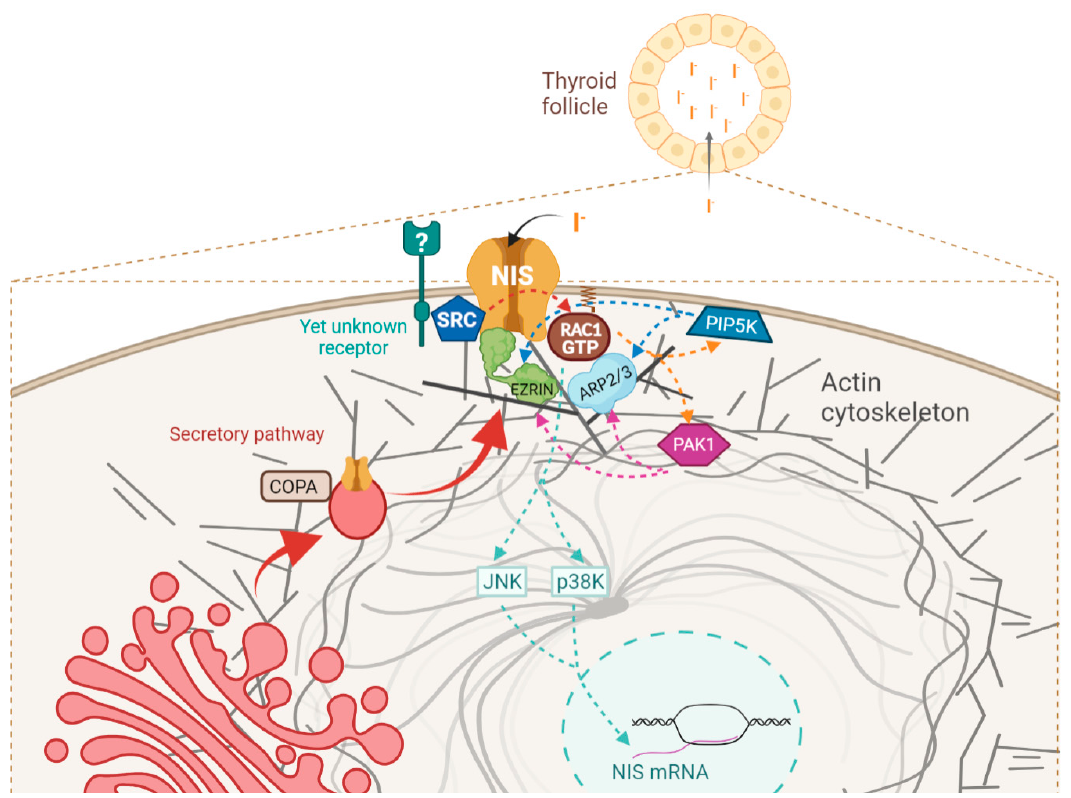
Figure 10. Diagram depicting the current model for the regulation of NIS functional residency at the PM by the SRC/RAC1/PIP5K/PAK/EZRIN/NIS pathway. In brief, NIS localization and function at the PM depends on its binding to SRC kinase, the activity of which, triggered by yet-unknown factors, leads to the recruitment and activation of the small GTPase RAC1. RAC1 signals not through p38 nor through JNK (two kinases downstream of RAC1 known to participate in the transcriptional regulation of NIS [59,60]), but through PAK1 and PIP5K. The combined activity of these kinases promotes ARP2/3-mediated actin polymerization, and the recruitment and binding of the actin anchoring protein EZRIN to NIS, promoting its residency and function at the PM of normal and TC cells. The figure was created with BioRender.com, accessed on 26 July 2021 .